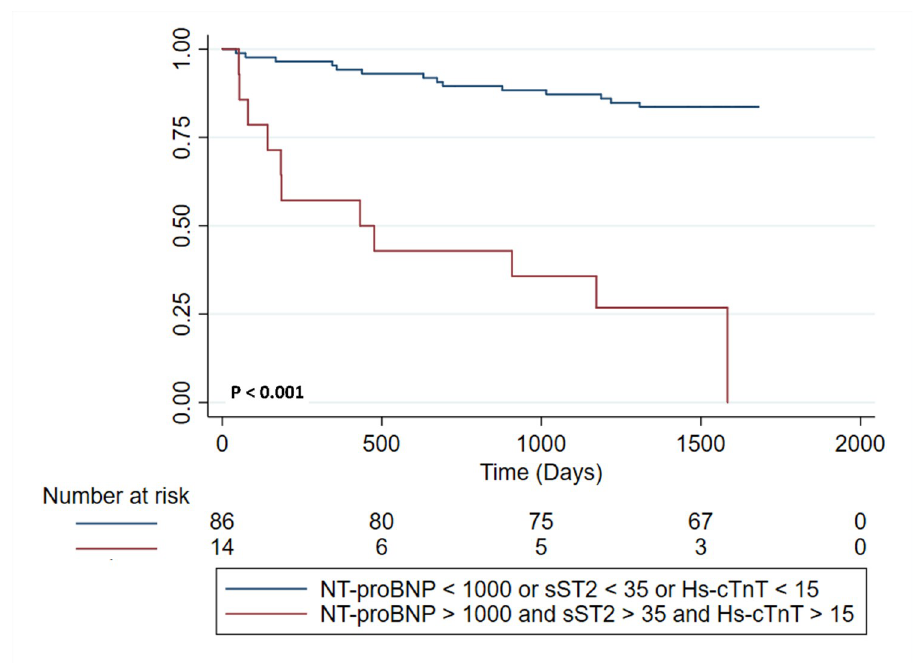
Fig 4. Kaplan Meier survival analysis for the composite outcome stratified by combined NT-proBNP, Hs-cTnT and sST2 according to selected cut-off values.